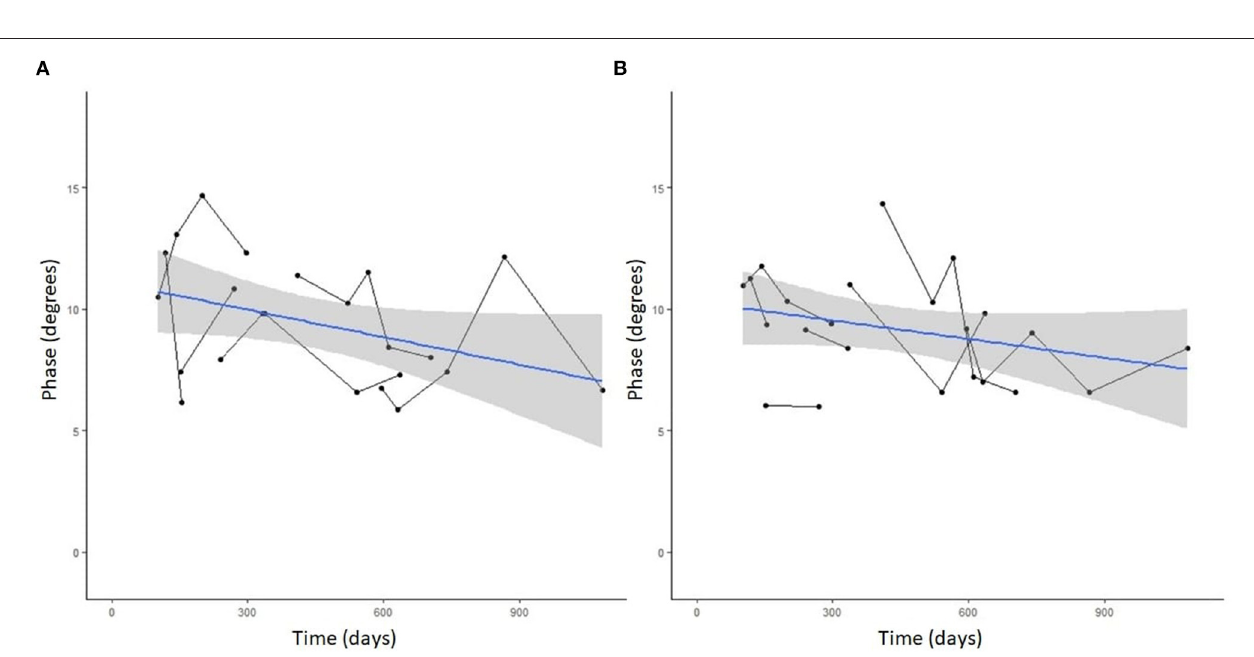
FIGURE 4 | Spaghetti plot highlighting EIM phase changes over time in the (A) left and (B) right gastrocnemius muscle in serially monitored dogs with DM. The time in days is measured from the onset of clinical signs attributable to DM. There is a gradual reduction of the phase value in the gastrocnemius muscle over time in dogs with DM.